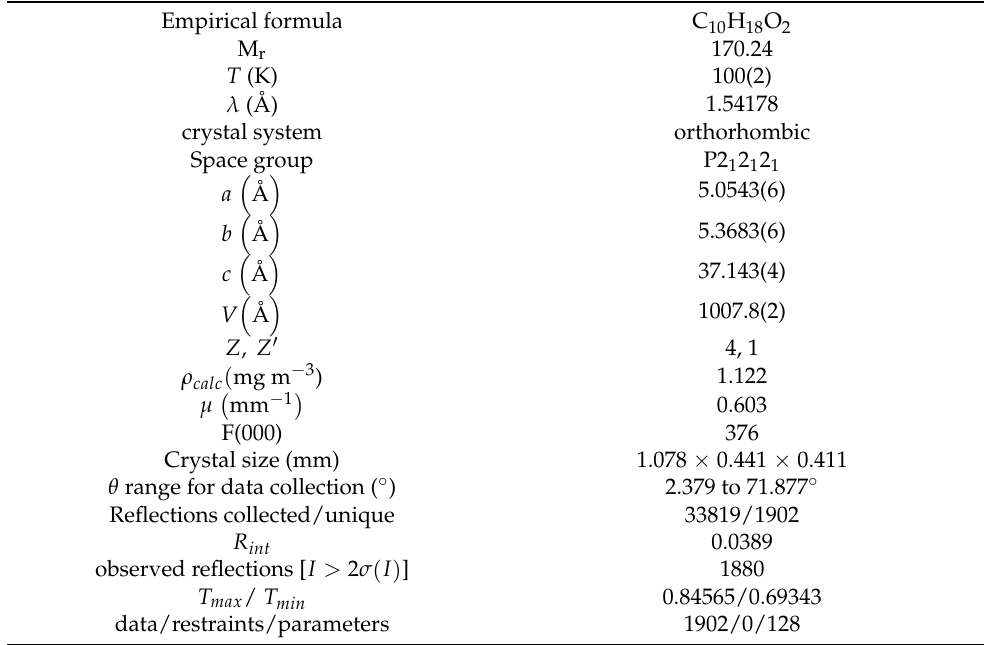
Table 1. Crystal data and refinement details for (+)- γ -Decalactone.